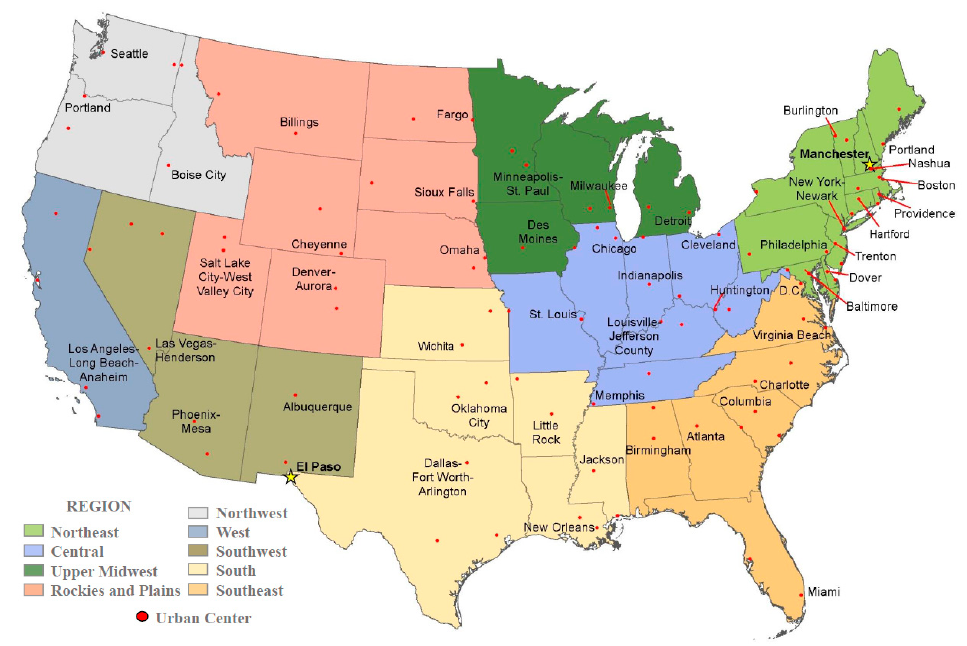
Figure A1. Climatic regions and selected urban centers.